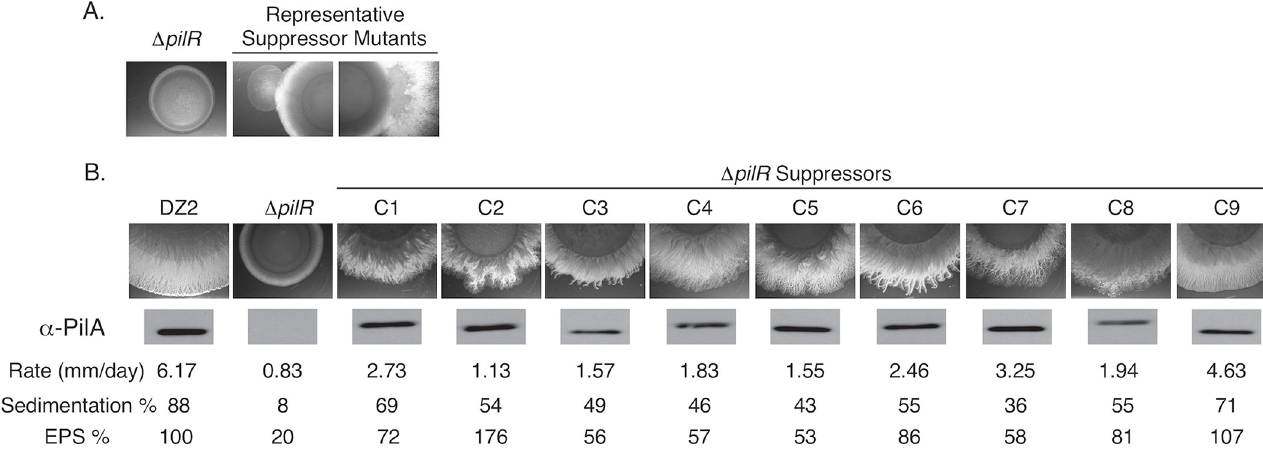
Fig 1. Characterization of M . xanthus Δ pilR suppressor mutants. (A) Representative suppressor mutations were observed after prolong incubation (7–14 days) on 0.5% agar. (B) Nine suppressor mutants were characterized for T4P-dependent motility related-phenotypes including motility rate (mm/day), sedimentation in static cultures reported as the percentage of lost absorbance at OD 600 after 2 hours, and extracellular polysaccharide (EPS) production measured by the binding of Trypan blue to whole cells in solution and normalized to wild-type DZ2 which was set at 100%. All data represent the averages of at least 3 biological replicates. All suppressor mutant (C1-C9) measurements were significantly different (t-test, p < 0.05) from wild-type DZ2 and Δ pilR with the exception of the EPS production of C6, C8, and C9 which were not different from that of the wild-type DZ2. Western blot analysis of total PilA from whole cell lysates was normalized to total protein determined by Bradford assay. All lysates were on the same blot, developed together, and can be directly compared to each other.